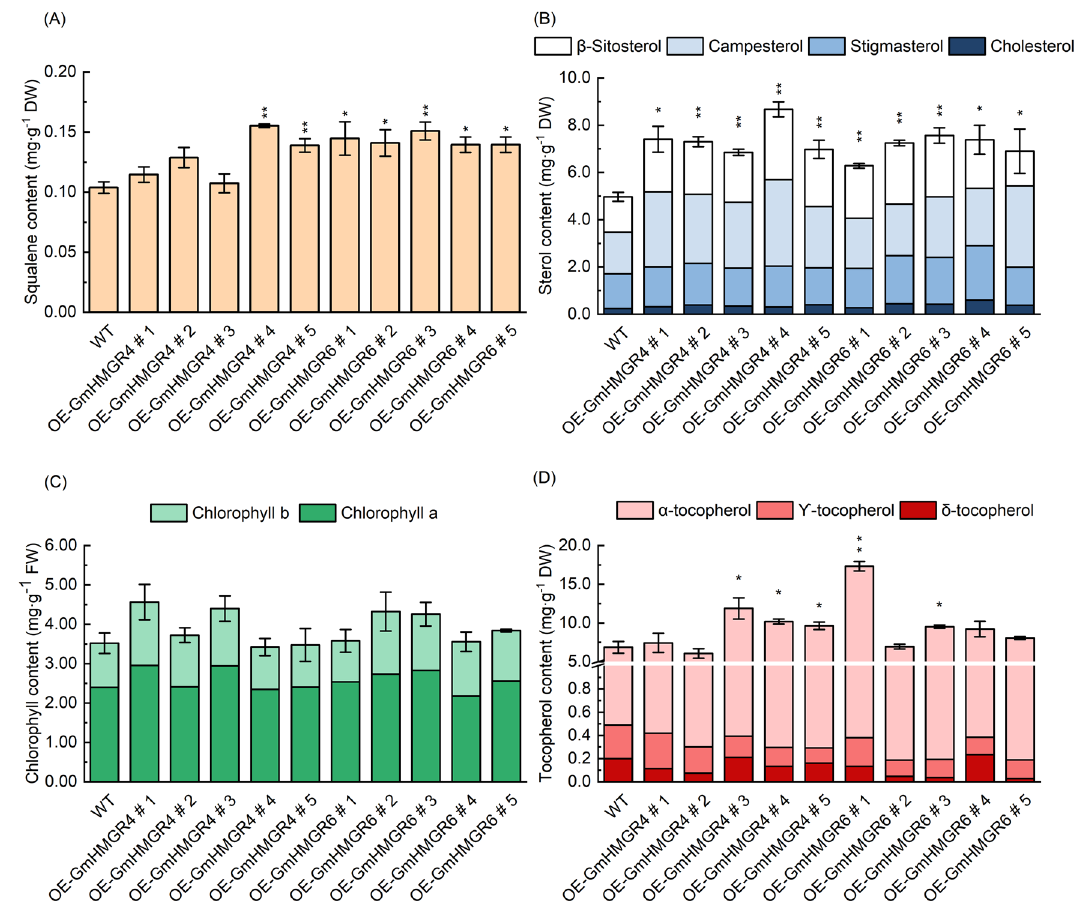
Figure 8. Content changes of squalene, sterols, chlorophyll, and tocopherol in overexpressed A. thaliana lines. ( A ) HPLC analysis of squalene content (mg·g −1 , DW) in A. thaliana . ( B ) HPLC analysis of sterol content (mg∙g −1 , DW) in A. thaliana , different colors represent β-sitosterol, campesterol, stigmasterol, and cholesterol. ( C ) Chlorophyll a and b content in leaves of A. thaliana (mg∙g −1 , FW). ( D) HPLC analysis of tocopherol content (mg∙g −1 DW), different colors represent α-tocopherol, ϒ -tocopherol, and δ-tocopherol. The data represent the mean ± SE of three biological replicates; the symbol * denotes significant difference from wild type (WT) at p < 0.05; ** at p < 0.01 by Student’s